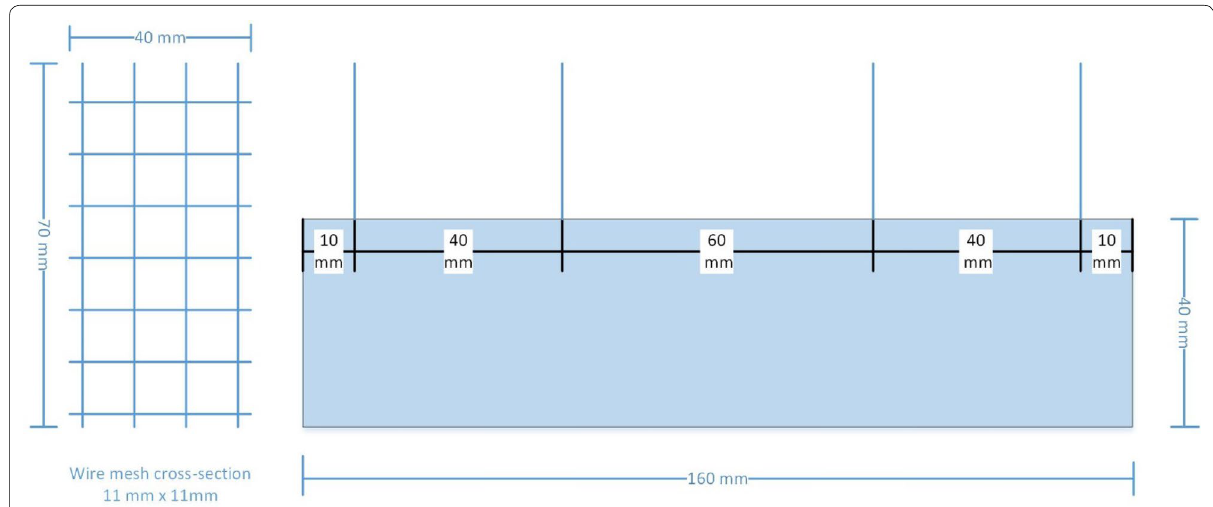
Fig. 1 Dimension of specimens for the measurement of electrical